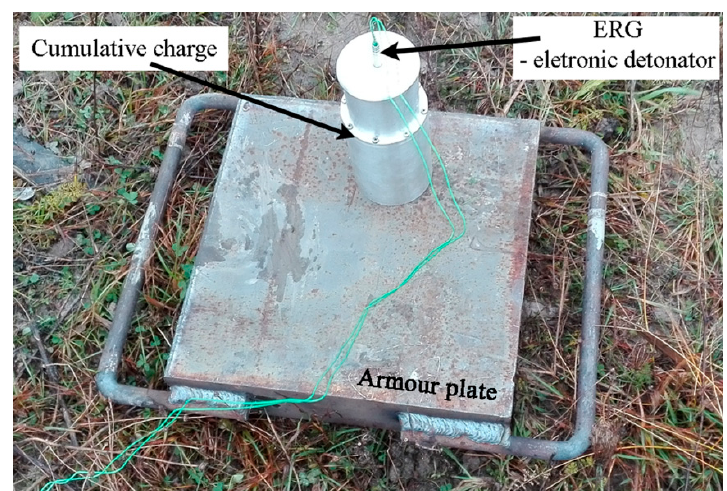
Figure 5. A way of loading the armor plate with a cumulative charge.